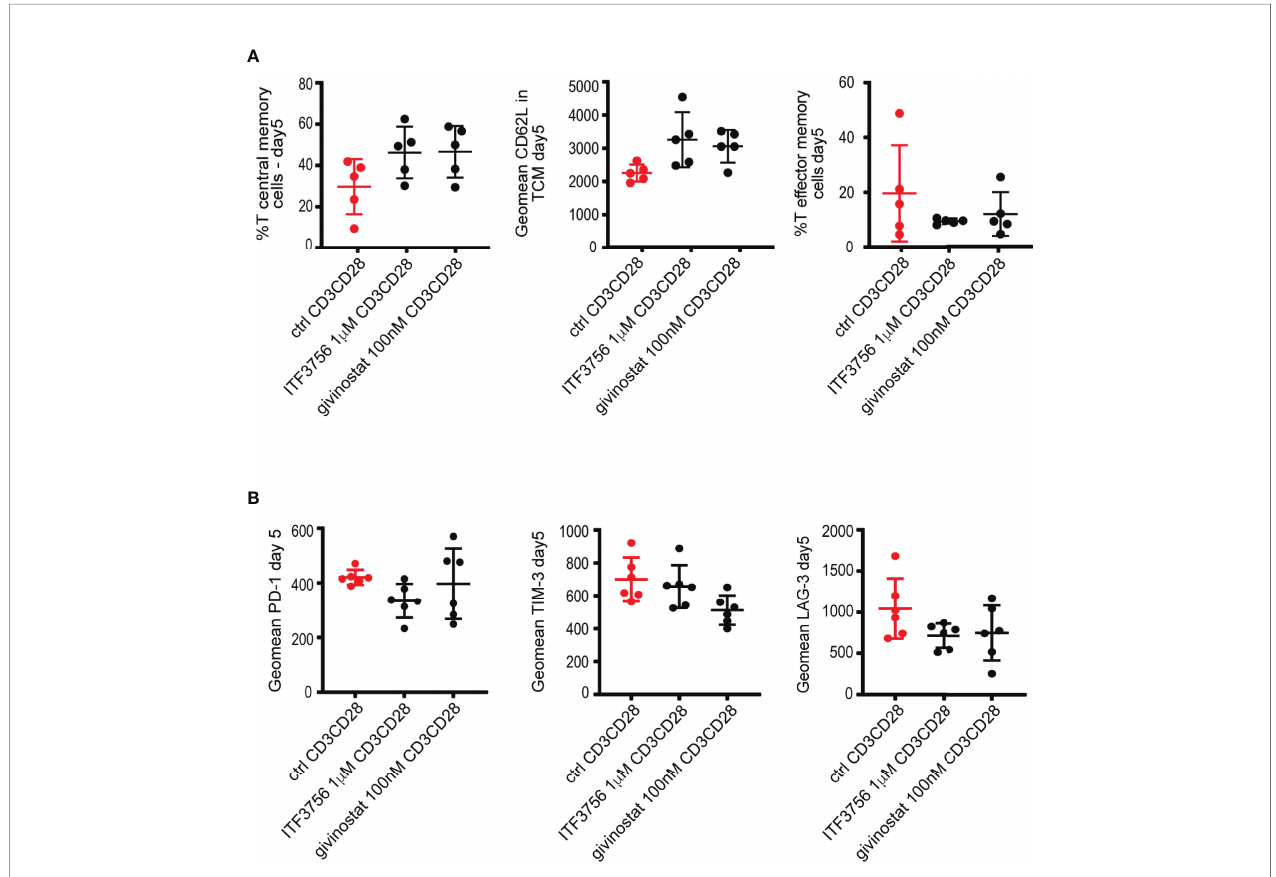
FIGURE 6 | HDACi treatment promotes T central memory phenotype and decreases T exhaustion markers in CD3CD28-stimulated CD8 + puri fi ed cells. Puri fi ed CD8 + cells were pre-treated with HDAC6i or Pan HDACi for 2 hours and then stimulated with anti-CD3/CD28 beads for 3 days followed by another run of stimulation in the presence of the inhibitors for 2 days. Cells were counted at the end of each stimulation period, beads removed, and cells placed in new medium with fresh beads for the next stimulation. Characterization of exhaustion markers and T cells phenotype was performed by fl ow cytometry. (A) T central memory (TCM) positive cells (CD45RO + CCR7 + CD62L + ), CD62L expression in TCM and T Effector memory cells (TEM) (CD45RO + CCR7 - CD62L - cells). (B) T exhaustion markers PD-1, TIM- 3 and LAG-3 as geomean fl uorescence intensity. Values on the graphs represent the mean± SD values of 3 experiments carried out on a total of at least 5 different donors. P values were calculated by RM one-way as described in material and methods. Geomean is the geometrical mean fl uorescence